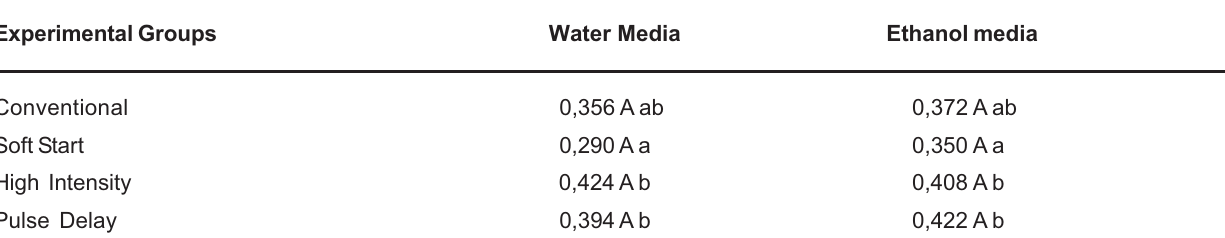
TABLE 3- Results of 2-way ANOVA